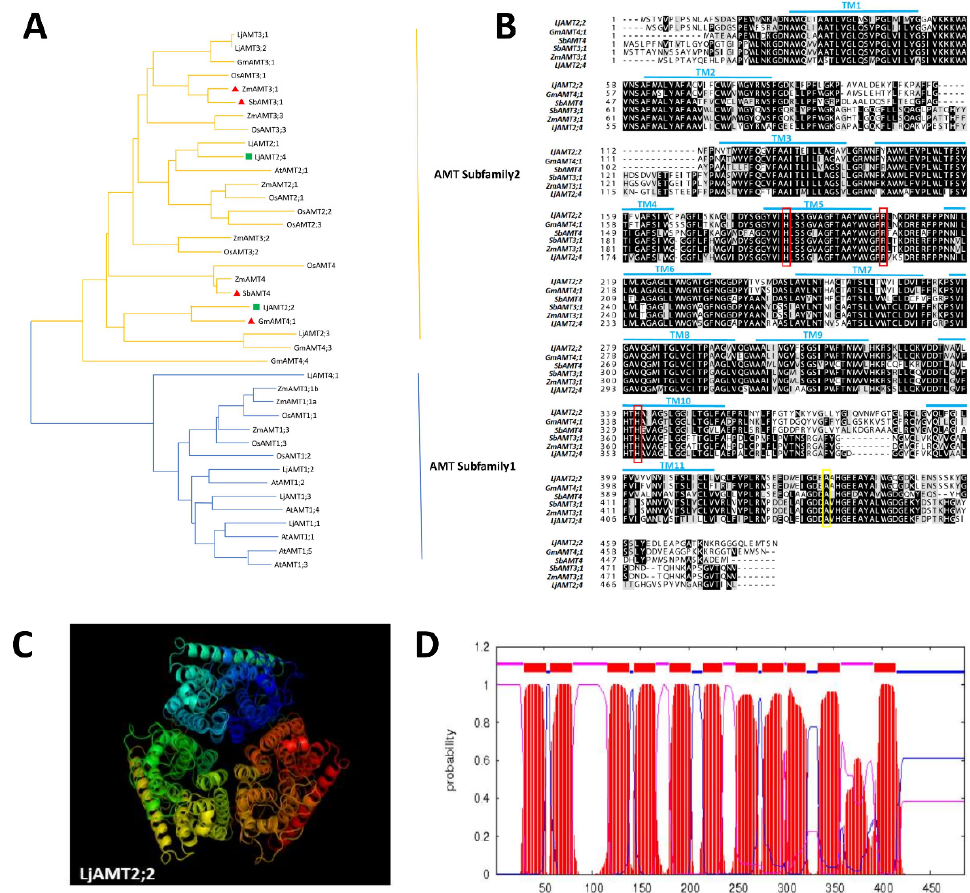
Figure 1. Bioinformatics analysis of the LjAMT2;2 gene. ( A ) Evolutionary analysis of the LjAMT family and AMT families in other species. ( B ) Amino acid sequence alignment of LjAMT2;2 with other reported AMT genes. Red lines indicate conserved ammonium transporter domains, and yellow lines indicate highly conserved domains. ( C ) Predicted three-dimensional structure of the LjAMT2;2 protein. ( D ) Distribution of transmembrane domains in LjAMT2;2. Purple represents the inner membrane, red represents the transmembrane, and blue represents the outer membrane .